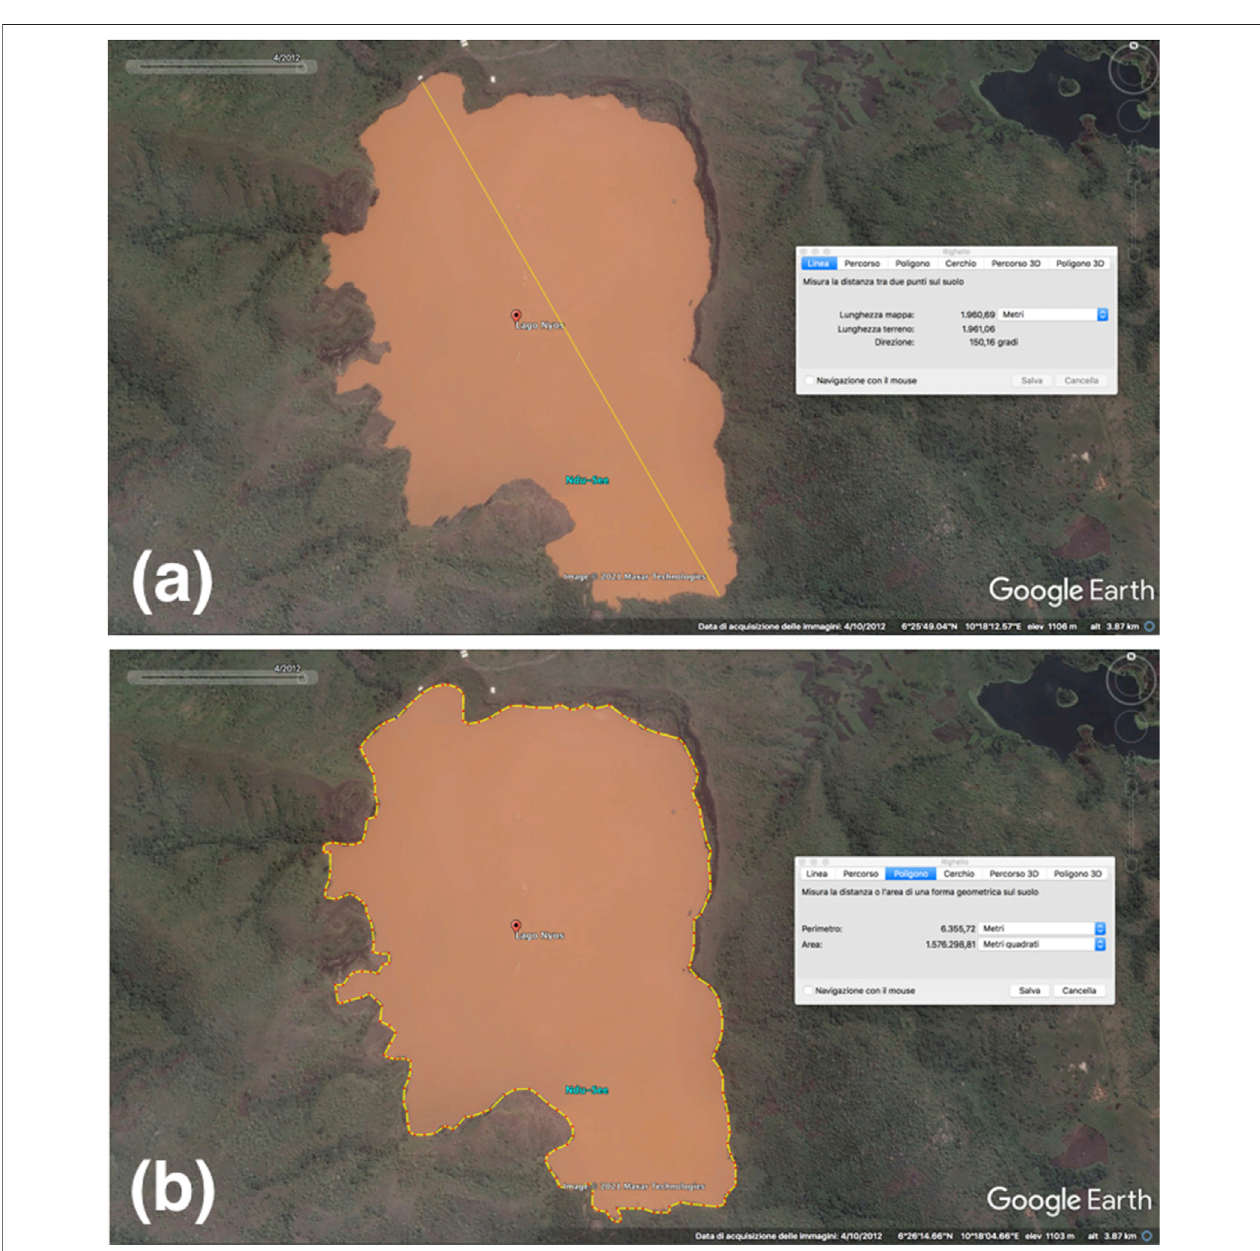
FIGURE 2 | (A) Ruler option to measure distances in GoogleEarth, (B) Polygone option to measure circumferences and surface areas in GoogleEarth (image © Maxar Technologies).